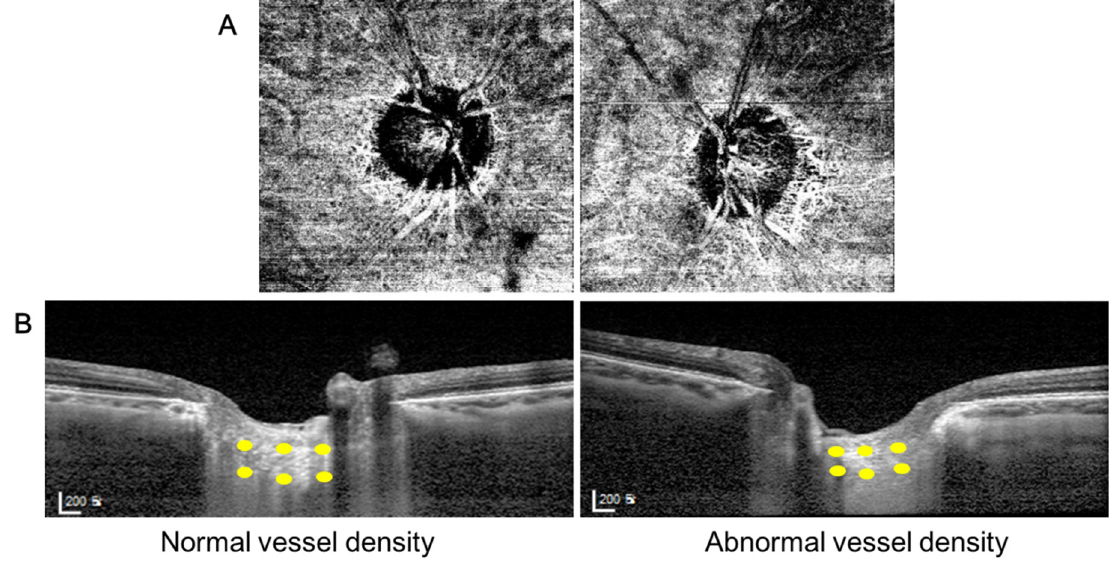
Figure 3. A representative case. ( A ) A 60-year old woman with decreased deep OCTA vessel density of peripapillary area in her left eye. ( B ) The thickness of lamina cribrosa in her left eye with abnormal vessel density was thinner than that in her right eye with normal vessel density.